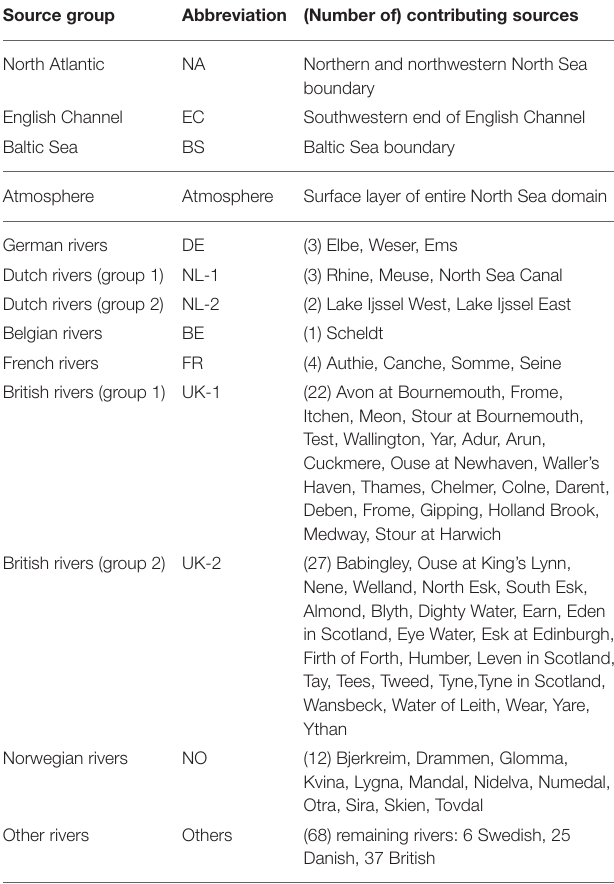
TABLE 1 | List of source groups defined for the TBNT analysis, including abbreviations (used in Figure 2 and in-text) and list of individual group